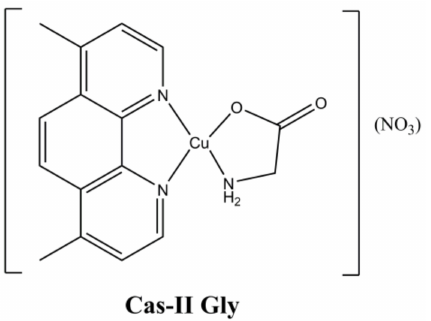
Figure 13. Structure of Cas-II Gly ([Cu(4,7-diMephen)(Gly)](NO 3